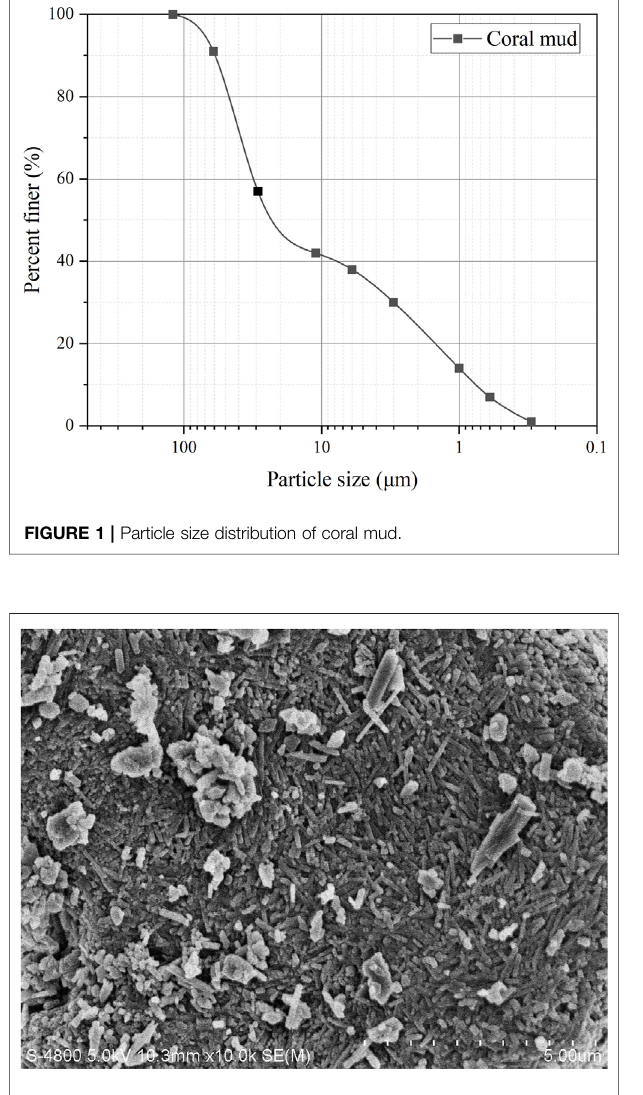
FIGURE 2 | SEM tests of coral mud.